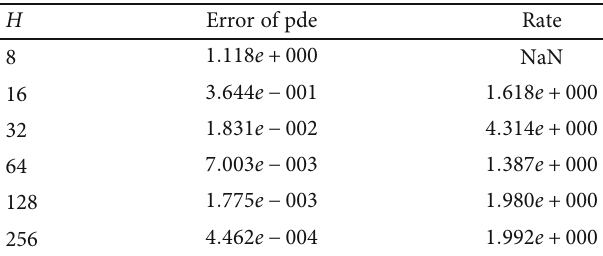
Table 1: Di ff erent